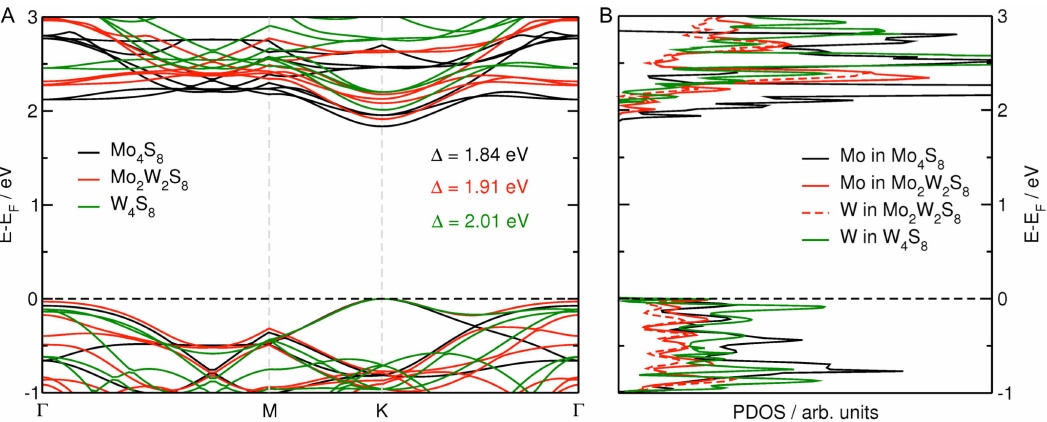
Figure 4. Electronic band structure ( A ) and density of states ( B ) of MoS 2 , WS 2 and Mo 0.5 W 0.5 S 2 systems. The fundamental band gaps are indicated. The projection of states is shown on metal atoms. The Fermi level is shifted to the valence band maximum. No spin-orbit coupling is taken into account.